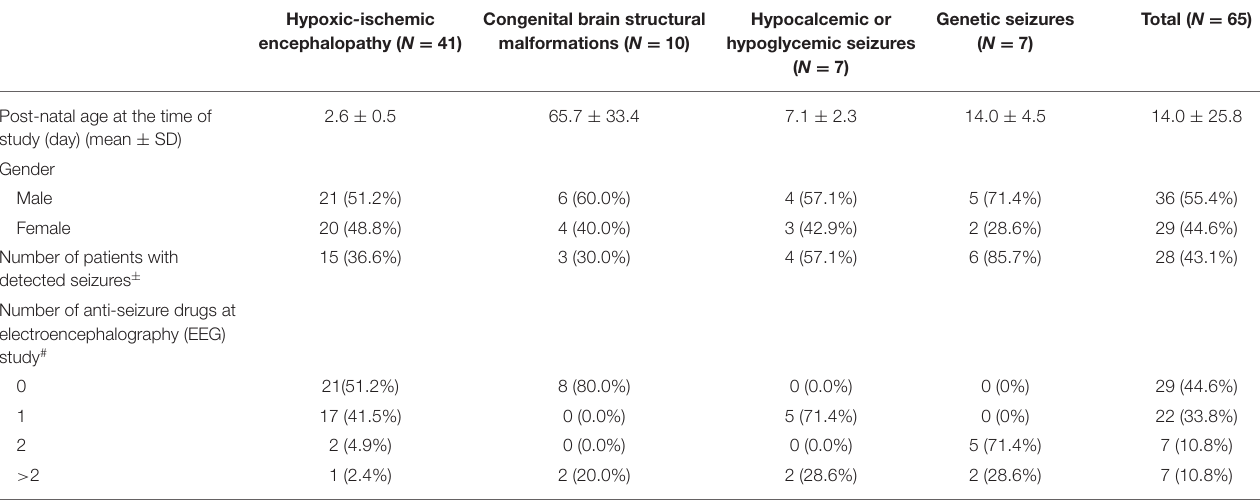
TABLE 1 | Demographic data of 65